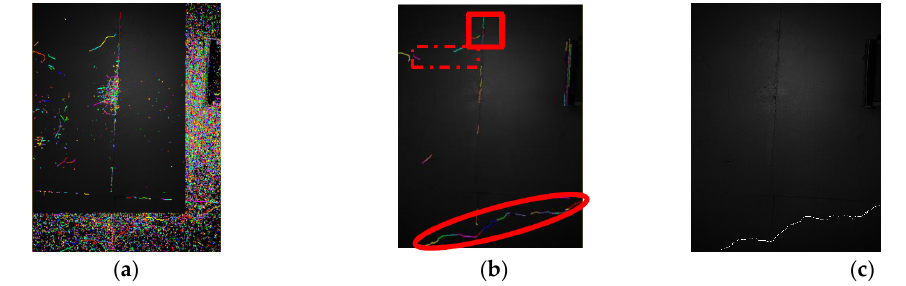
Figure 8. The crack detection result of image 2 by the algorithm in this paper: ( a ) DPG detection results; ( b ) coarse screening results; ( c ) crack extraction results after broken connection.